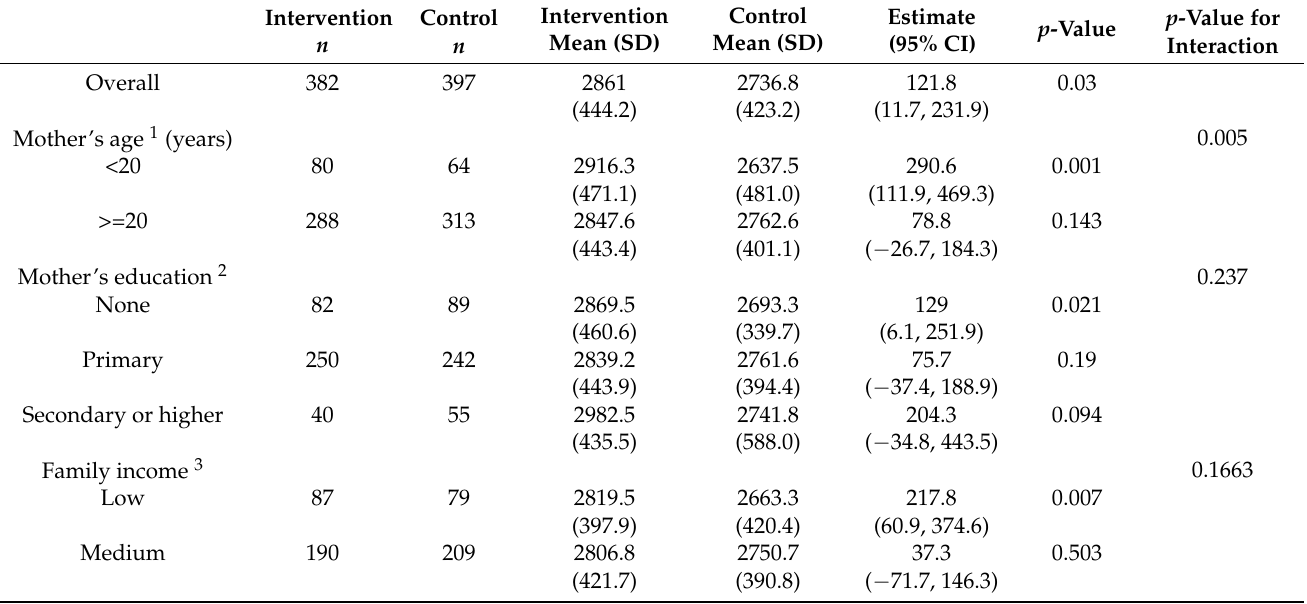
Table A1. The mean birth weight and the adjusted mean difference in birth weight of balanced-plate intervention compared to usual